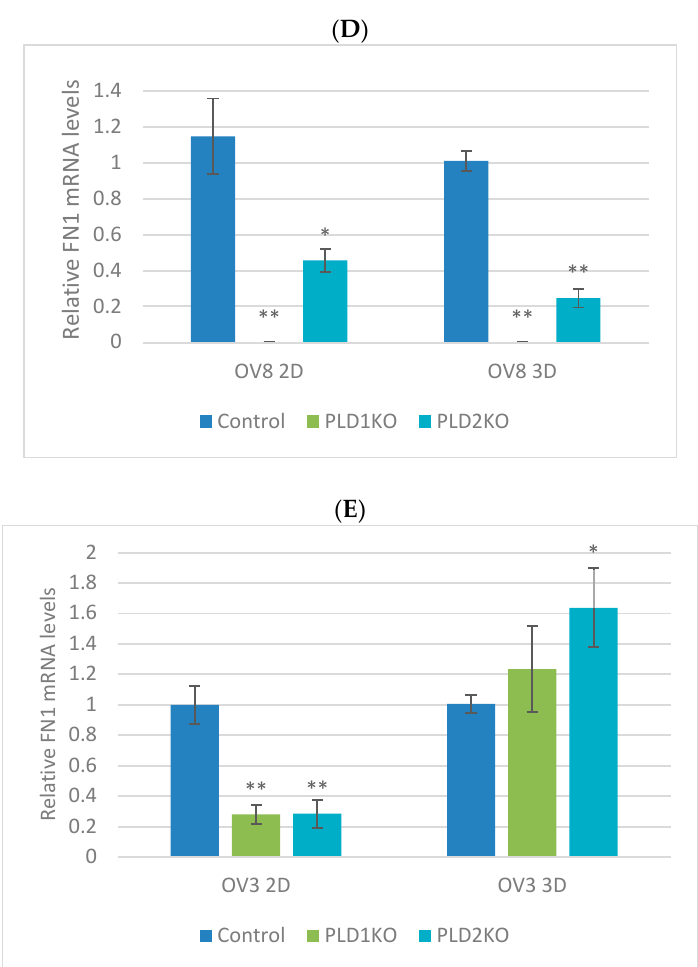
Figure 4. qPCR of vimentin, fibronectin and E-cadherin. Relative qPCR expression of E-cadherin ( A ), vimentin ( B,C ) and fibronectin ( D,E ) in OVCAR3 and OVCAR8 cells cultured in monolayer and spheroid form. * p < 0.05, ** p < 0.01.